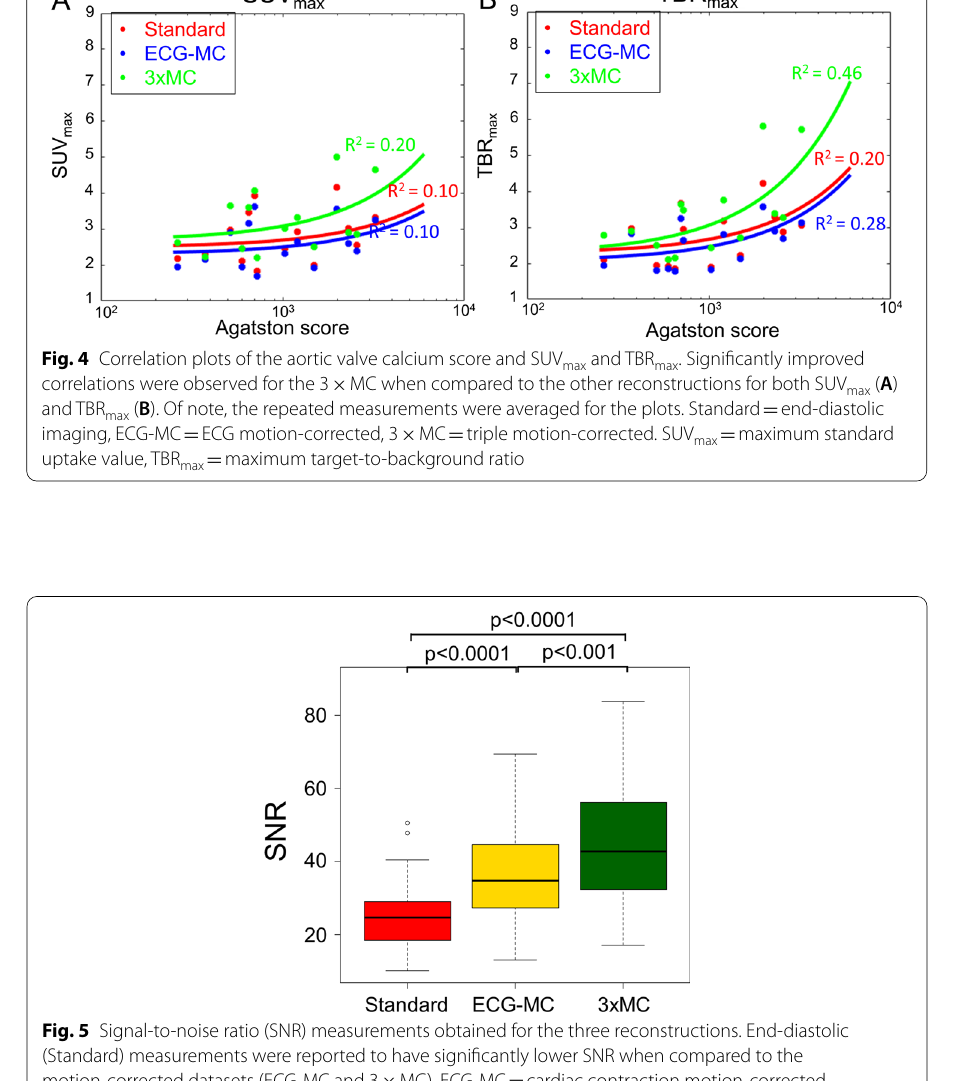
MC). ECG-MC cardiac contraction motion-corrected, × =